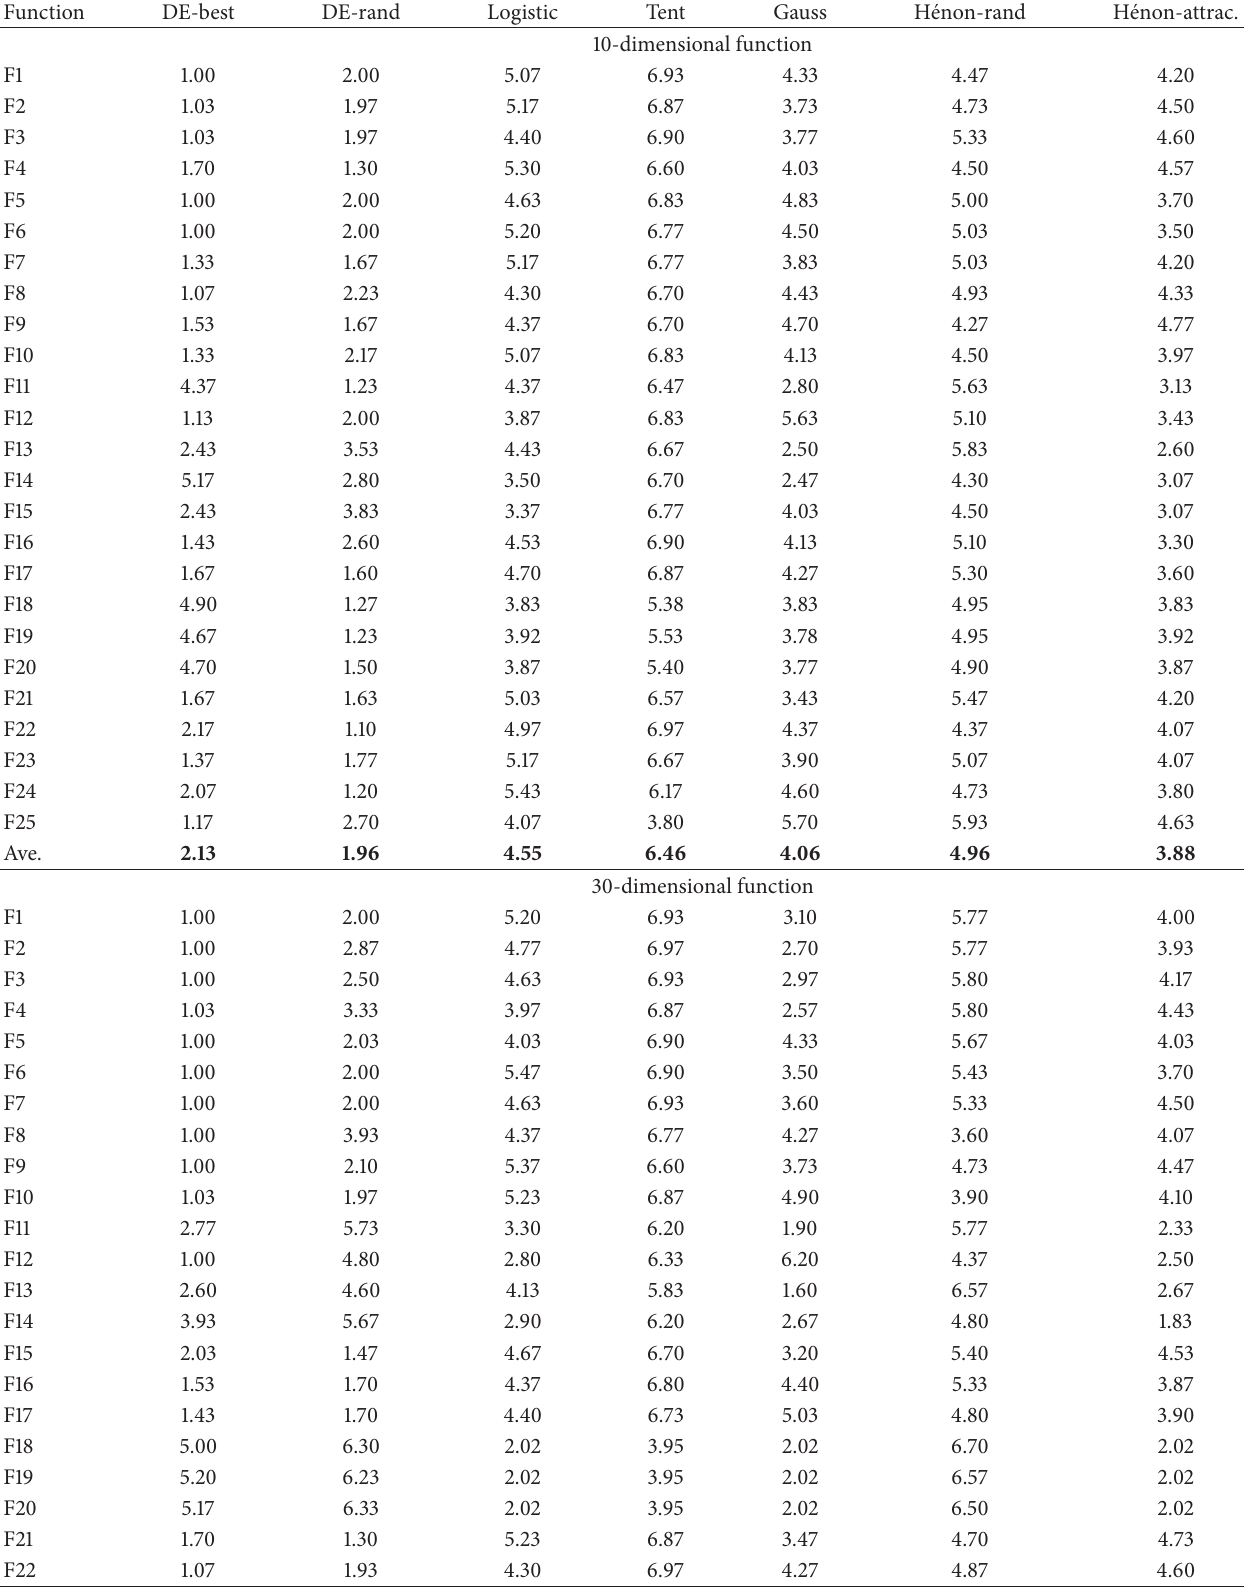
Table 6: Algorithms’ rank with DE by Friedman test for F1–F25 of 10D and 30D, respectively. The abbreviation meanings are in Table 2. Function